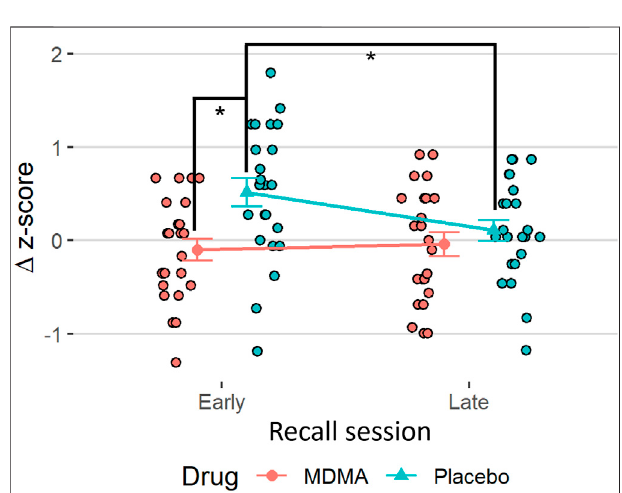
FIGURE 3 | MDMA promotes extinction recall. The difference in standardized values ( Δ z-scores) between the trial types (conditioned fear stimulus [CS+] minus conditioned safety stimulus [CS − ]) of the skin conductance response task in the recall. Subjects after MDMA showed signi fi cantly less discrimination between CS+ and CS − compared to the placebo session. Stats are from Tukey posthoc tests following an interaction of drug × time in delta values [(F1,22) = 6.74, p = 0.017]. * p < 0.05. MDMA,